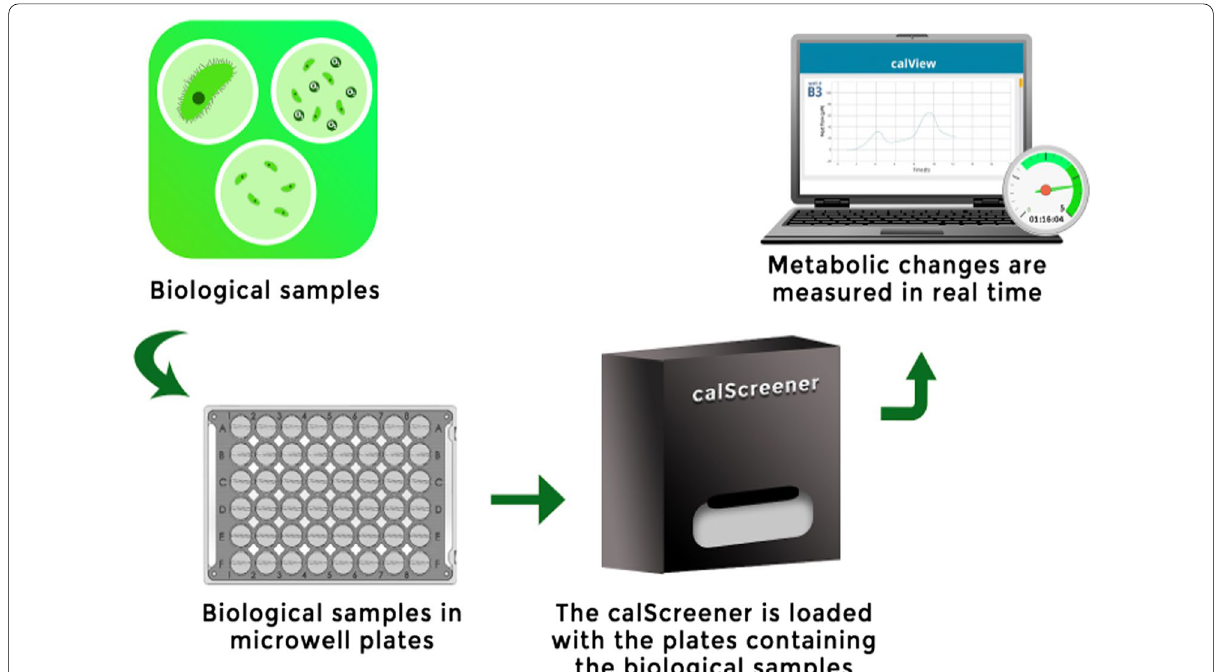
Fig. 1 Schematic framework of the isothermal microcalorimetry calscreener in metabolism measurement of biological